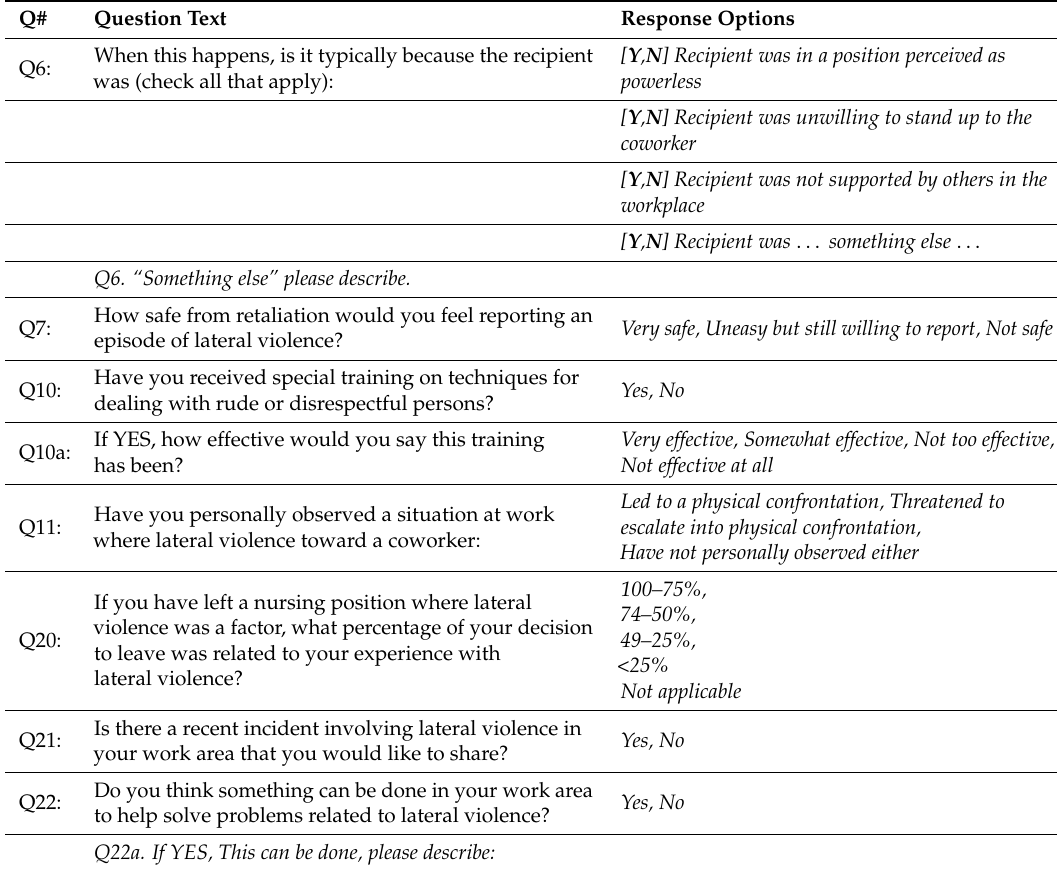
Table 4. Items that asked about other aspects of lateral violence in the